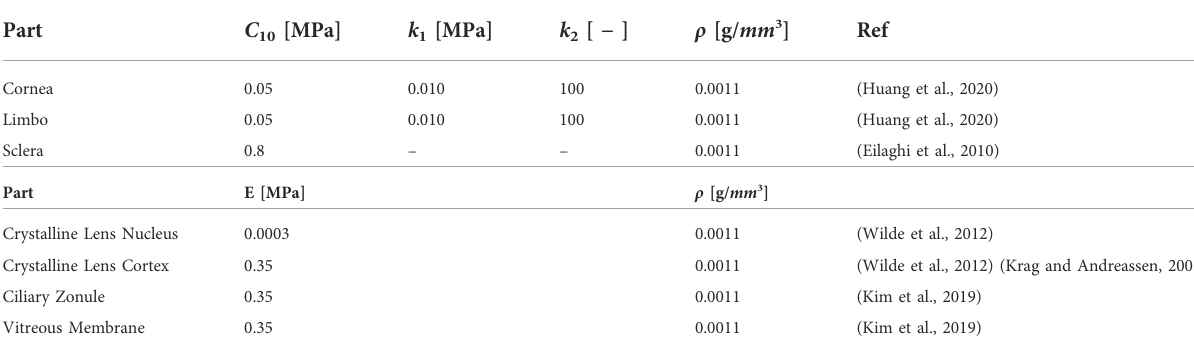
TABLE 1 Material parameters of the different eye tissues incorporated in the fi nite element model.